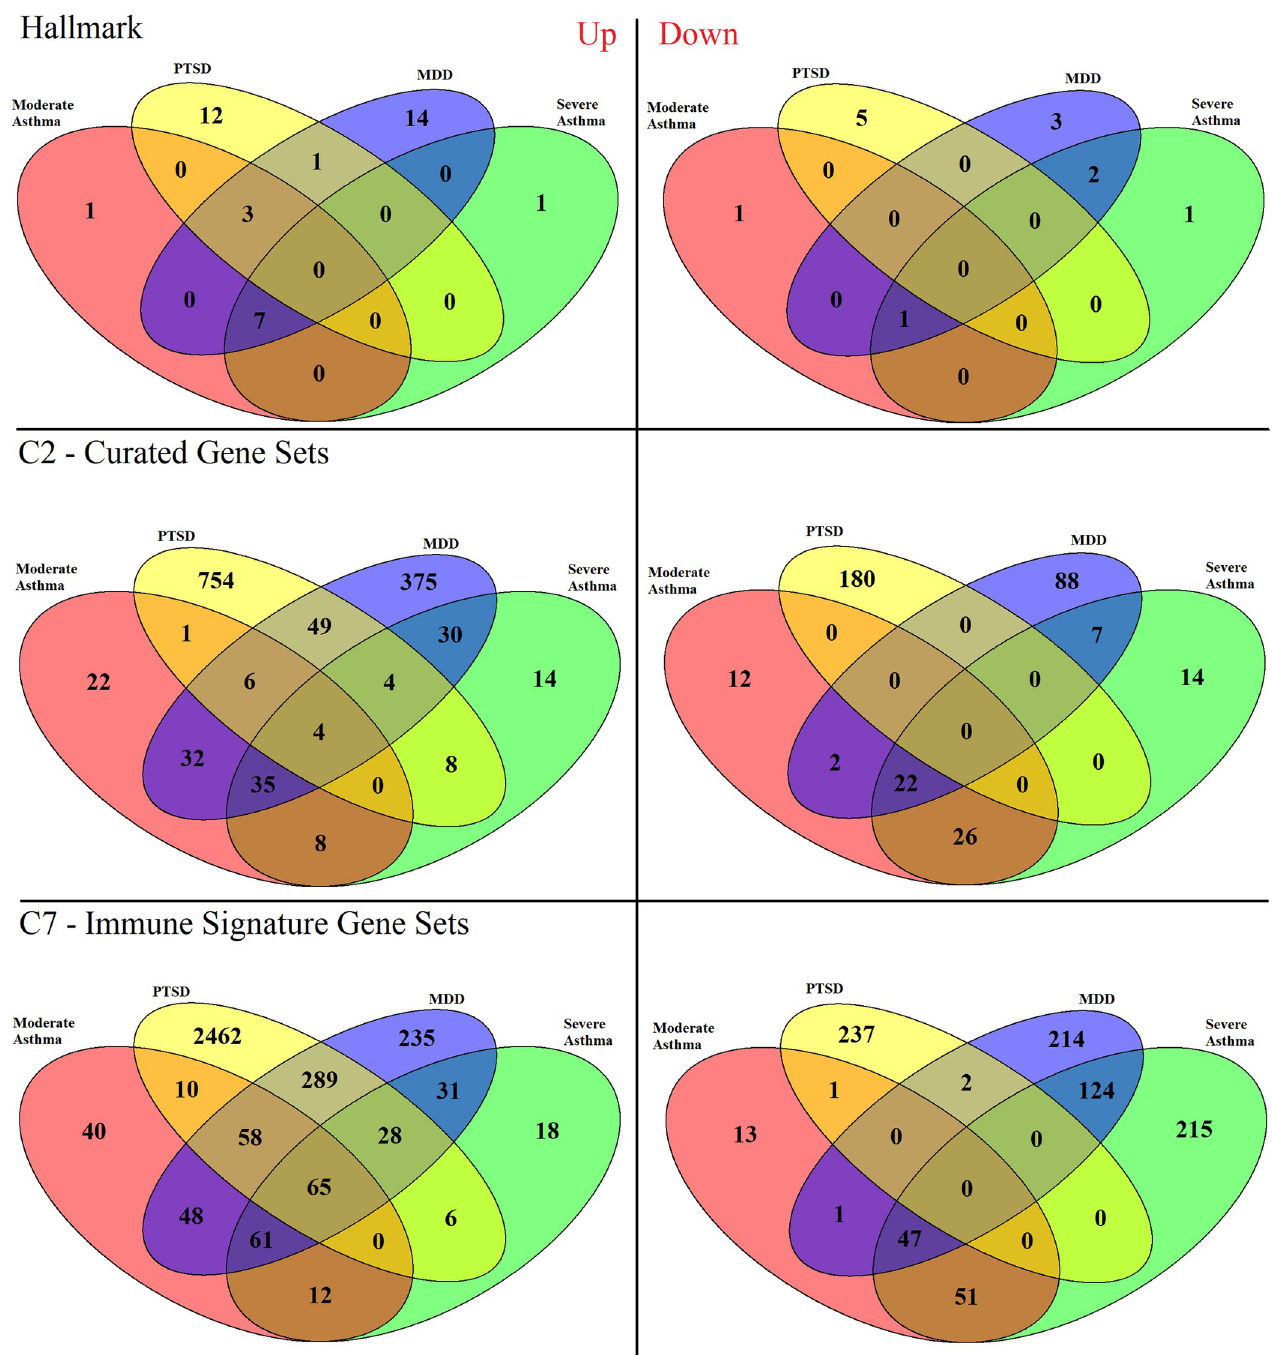
Fig 4. Gene set enrichment analysis. (GSEA) showing significantly (adjusted P-value < 0.05) modified pathways between all 4 exploration datasets. Labels identify the gene sets being compared to and in which direction (left = upregulated, right = downregulated).